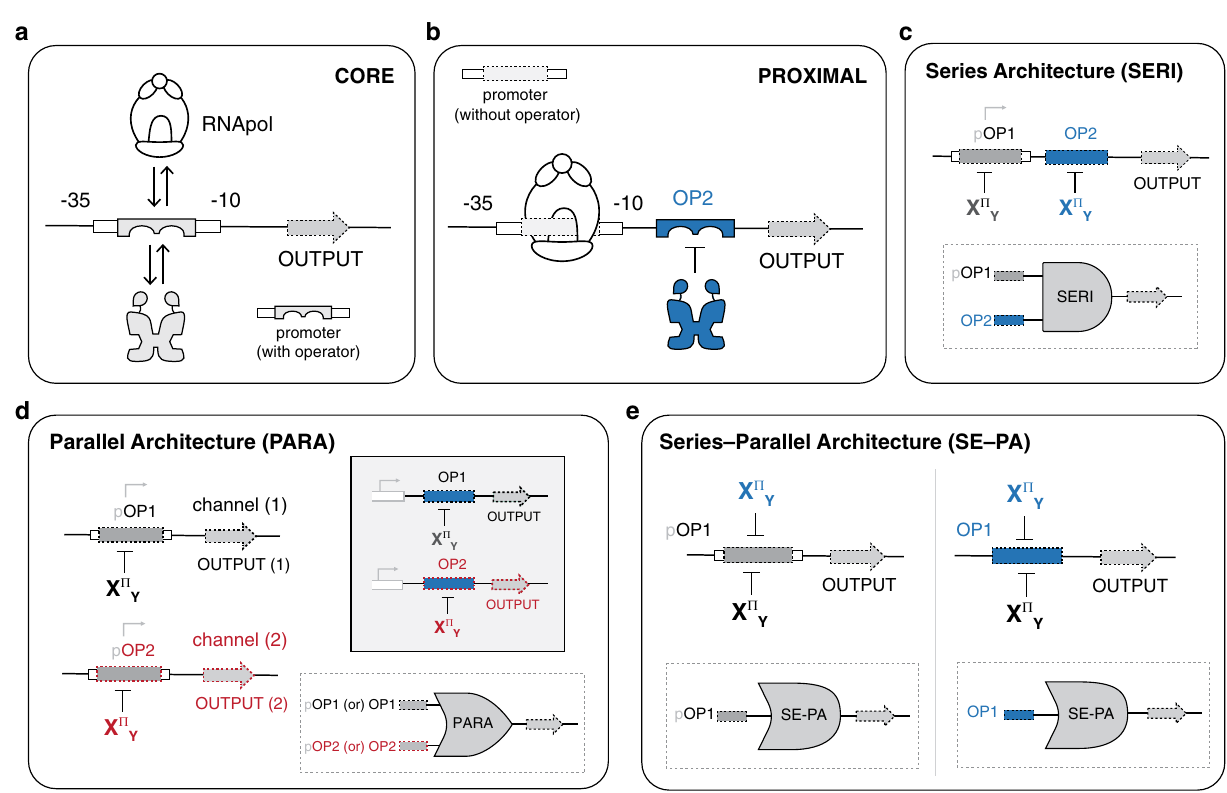
Fig. 3 Mechanisms and architectures for directing TFs. a , b Illustrates the putative mechanisms for single transcription factor interactions at two distinct DNA operator locations, while c – e show architectures that facilitate combinatorial logical operations. a Core architecture, where the operator is positioned intercalated with (or between) the − 35 and − 10 hexamers of the bacterial promoter, both upstream of a gene OUTPUT. Mechanistically, the transcription factor and RNA polymerase compete for binding to the promoter-operator region. b Proximal architecture. The operator is located between the promoter (beyond the − 10 hexamer) and the gene OUTPUT. Here, RNA polymerase and the transcription factor can independently interact with the promoter and operator elements, without competition. c Series (SERI) architecture, consisting of one operator each, core and proximal. Transcription factors interact with distinct operators, though the one directed to the core position must compete with RNA polymerase. Note: pOP indicates an operator within a promoter. d Parallel (PARA) architecture, with two channels. Each channel consists of a separate operator (core or proximal, inset) controlling a distinct OUTPUT, which could be coupled. e Series-parallel (SE-PA) architecture. A single operator, at the core (left) or proximal (right), is regulated by multiple transcription factors via shared DNA-binding domains. This is mechanistically distinct from both the series and parallel architectures, as TFs must work in tandem to regulate gene OUTPUT (i.e., interactions are independent and exchange on a single operations developed in this study is provided in Supplementary Fig. 8. In turn, we conducted a correlation analysis to identify all unit operations that performed approximately equal to (or greater than) the reference unit operation (Fig. 5c, d). At the proximal position nine unit operations had a fold anti-induction (dynamic range) greater than or approximately equal to the reference unit operation. Whereas, at the core position 25 unit operations had fold anti-induction values that were on par or greater than the reference system. In most cases unit operations at the core position resulted in larger dynamic ranges. However, two anti- repressors resulted in greater ranges at the proximal position (R A (2) A(1) KSL , and R TAN ) over the core position, Supplementary Fig. 8. Notably, the dynamic range has been regarded as the principal performance metric for a given unit operation. However, metrics that can determine compatibility between sets of unit operations should be considered equally important, see Fig. 5e. Toward this end, repression units (RU) provide information regarding the ON state of a NOT unit operation, and the OFF state of a BUFFER unit operation (i.e., the unit operation without the input ligand — in general). Case in point, paired NOT logical operations with extreme differences in RU (e.g., approximately 10-fold or greater) may not be compatible. This is especially true when pairing NOT